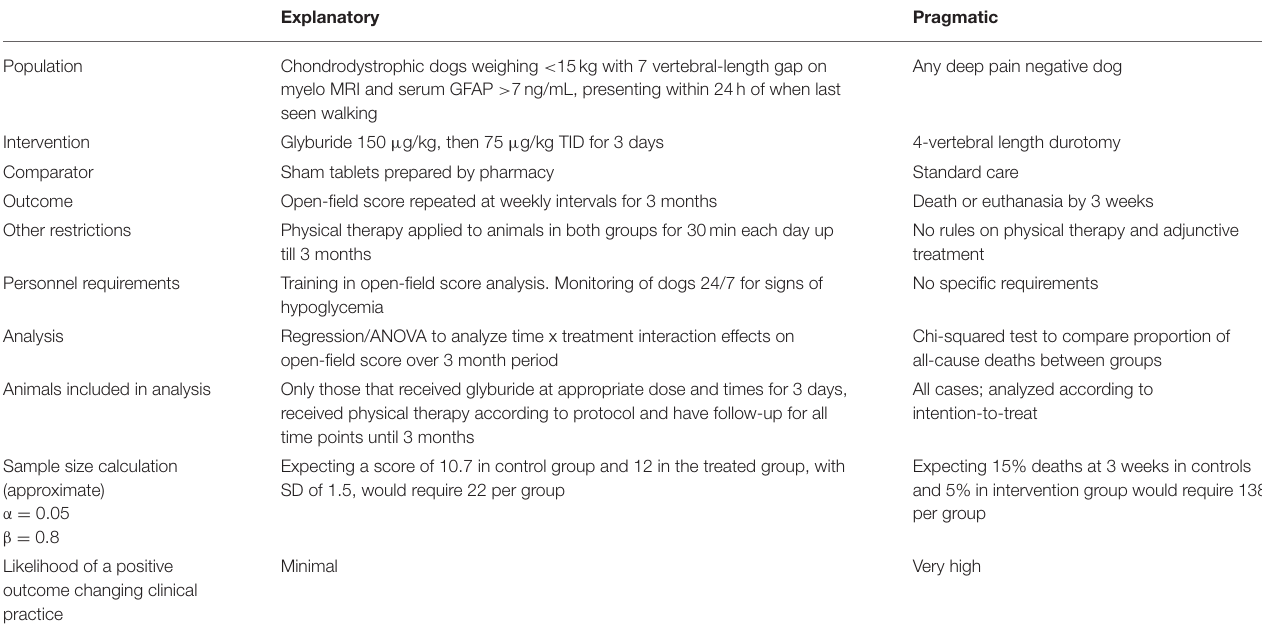
TABLE 1 | Outline of two contrasting example approaches to spinal cord injury trials in